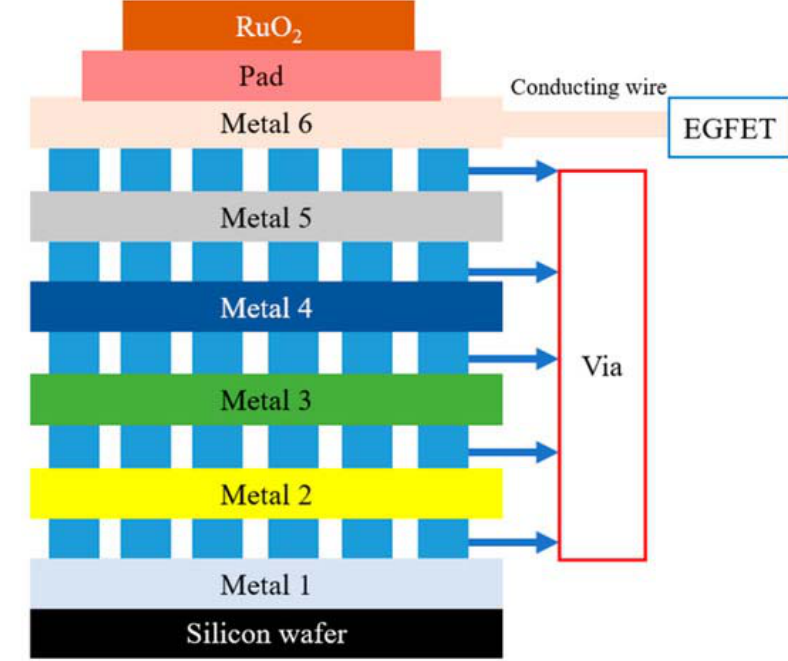
Figure 9. Fabricated device structure. Pad = connection pad.